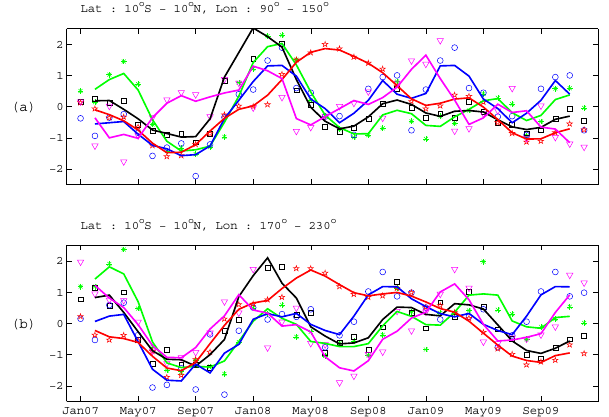
Figure 10. Same as Fig. 9 except for the equatorial region. The z score of monthly mean of OLR were also plotted (triangle point and magenta